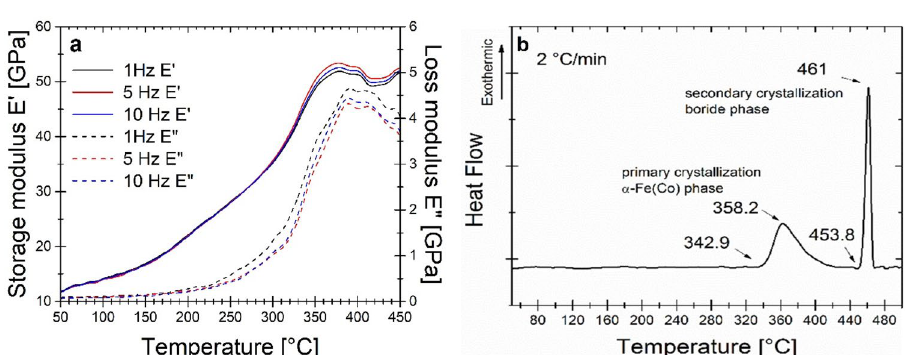
Figure 4. ( a ) DMA results of storage modulus E’ and loss modulus E” at the heating rate 2 °C/min; ( b ) DSC signal at the heating rate of 2